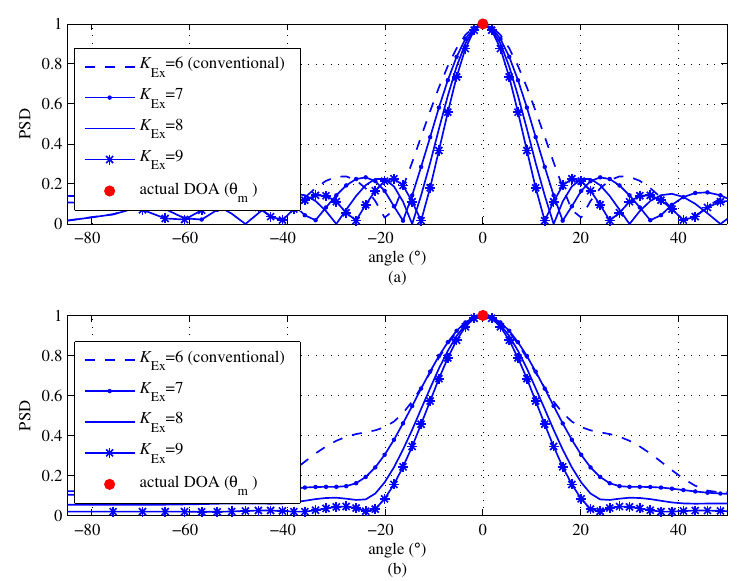
Figure 4. Discrete Fourier transform results of the proposed scheme according to the number of e ff ective channel signals K Ex for a single target with K = 6, signal to noise ratio (SNR) = 10 dB and N = 64 ( a ) without Hanning windowing; ( b ) with Hanning windowing.